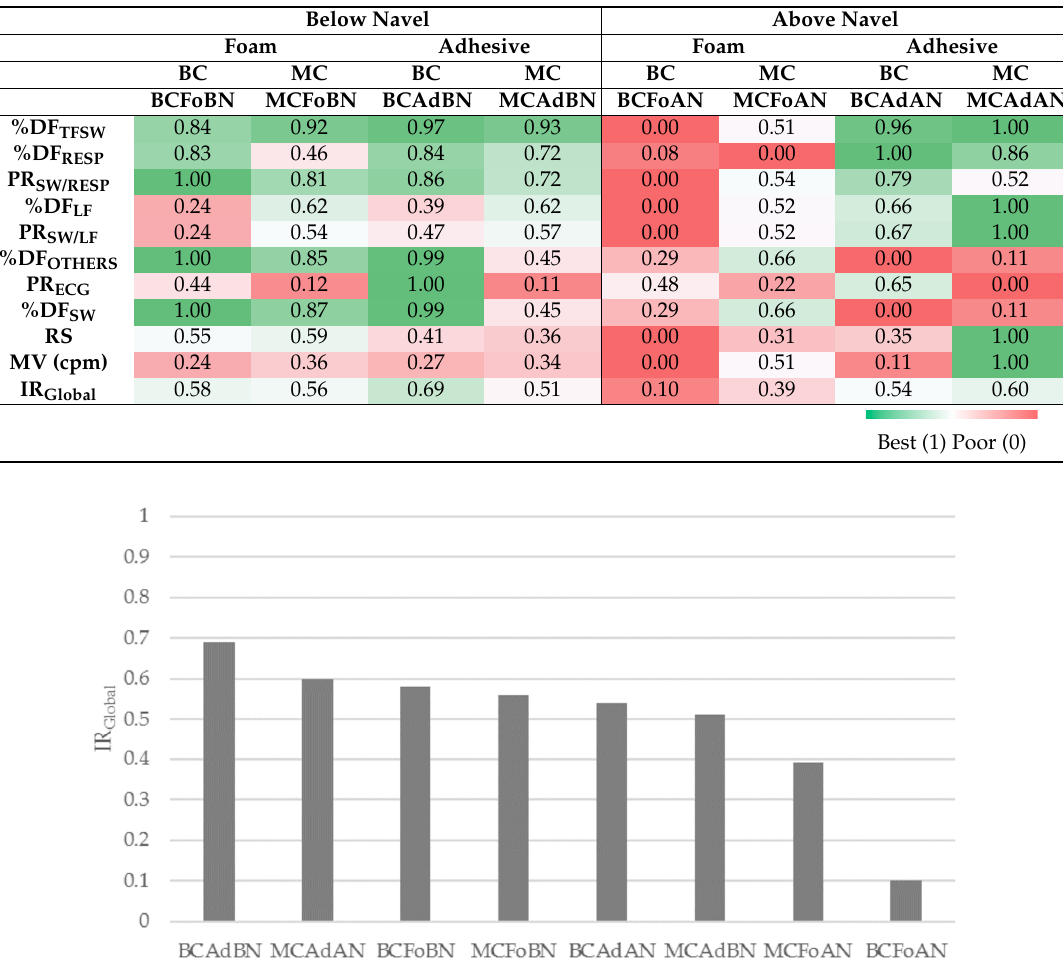
Table 6. IR values for the concentric bipolar records (BC1-EEnG, BC2-EEnG, BC3-EEnG, BC4-EEnG) in BN position and using adhesive material and conventional bipolar (BIP) in BN position, for the 10 characteristic signal parameters.